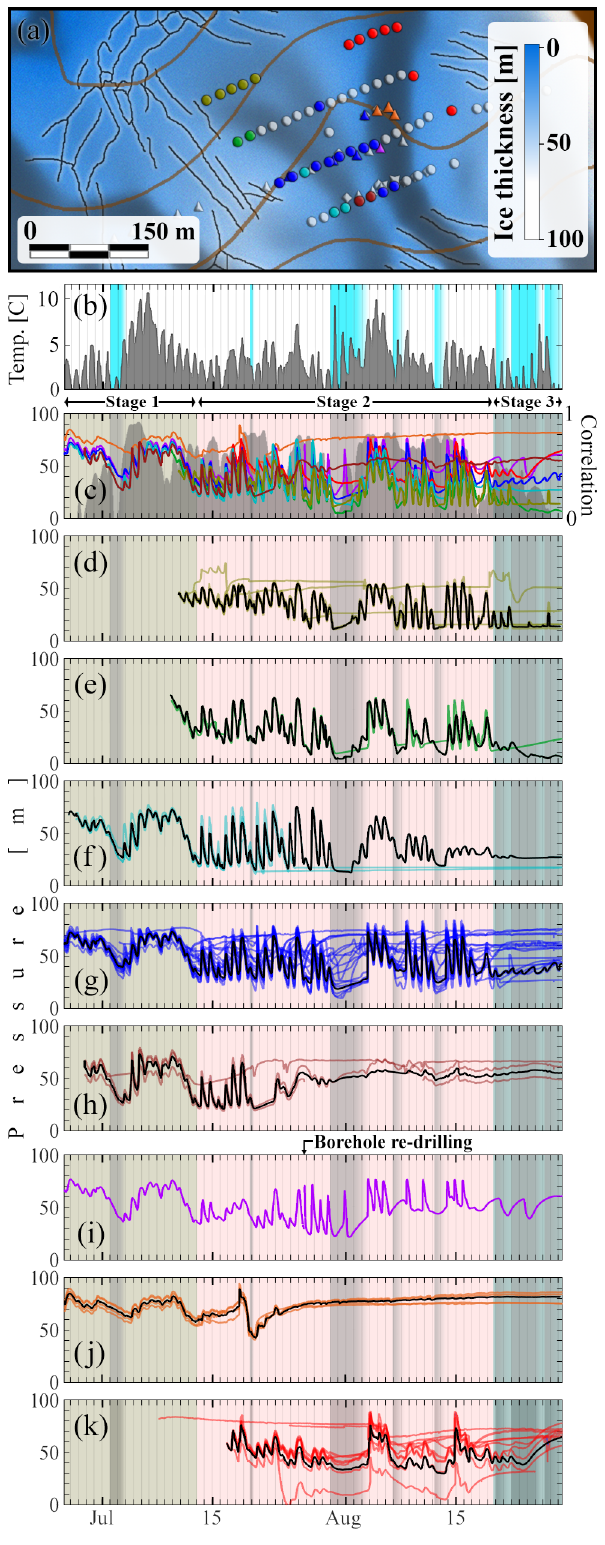
Figure 11. Locations and pressure time series for all 42 boreholes shown in Fig. 9b, grouped according to the similarities between their diurnal pressure variations in July–August 2015, same plotting scheme as in Fig. 5. (a) The map area is indicated as a box in Fig. 9a. Grey shading is the upstream area shown in Fig. 2. (b) Air tem- perature (grey) and fresh snow cover (light blue). (d–k) Borehole pressure time series, the colour of plots corresponds to the colour of borehole marker on the map. Black lines are the mean pressure in each panel, computed only over those boreholes that are “con- nected” at a given time (see main text); the black lines frequently obscure one of the borehole time series. (c) The black “mean” curves from panels (d) – (k) , plotted in the corresponding borehole marker colour. The maximum cross-correlation coefficients, allow- ing for time lags of up to 6h, between all pressure records and air temperature computed over a moving three-day window is shown in dark